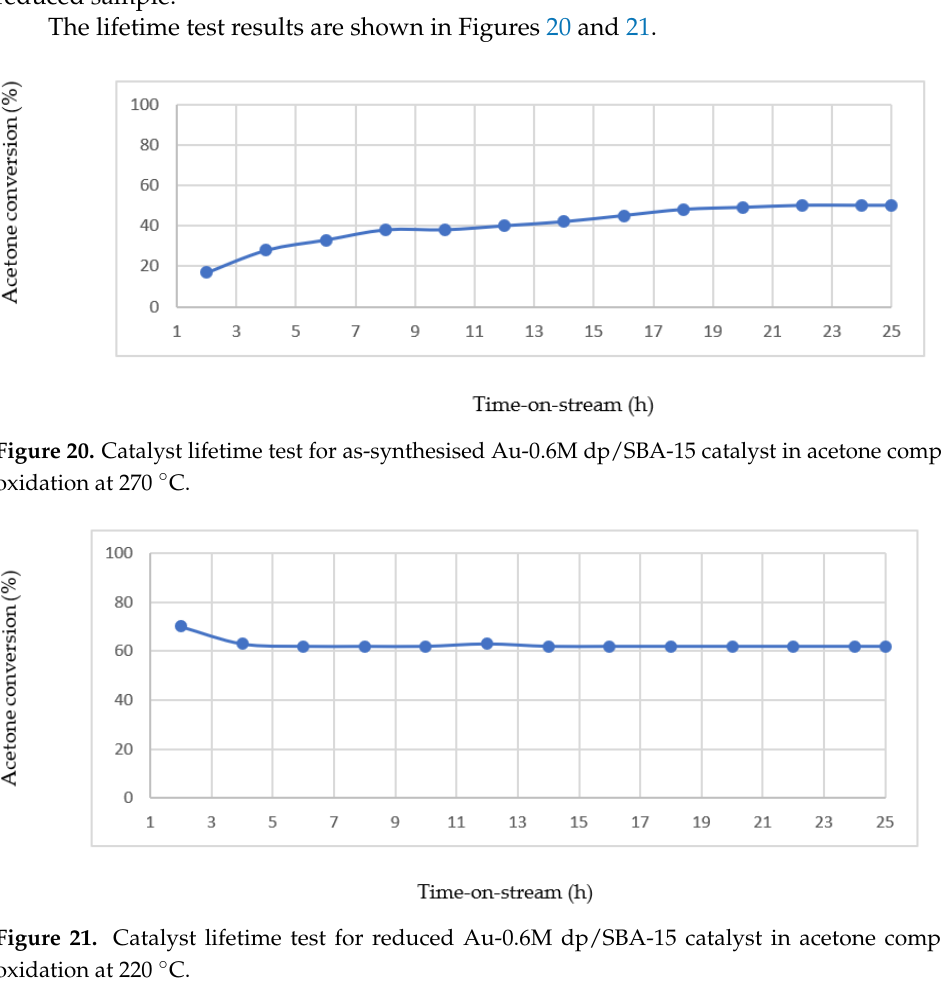
Figure 21. Catalyst lifetime test for reduced Au-0.6M dp/SBA-15 catalyst in acetone complete oxidation at 220 ° C.